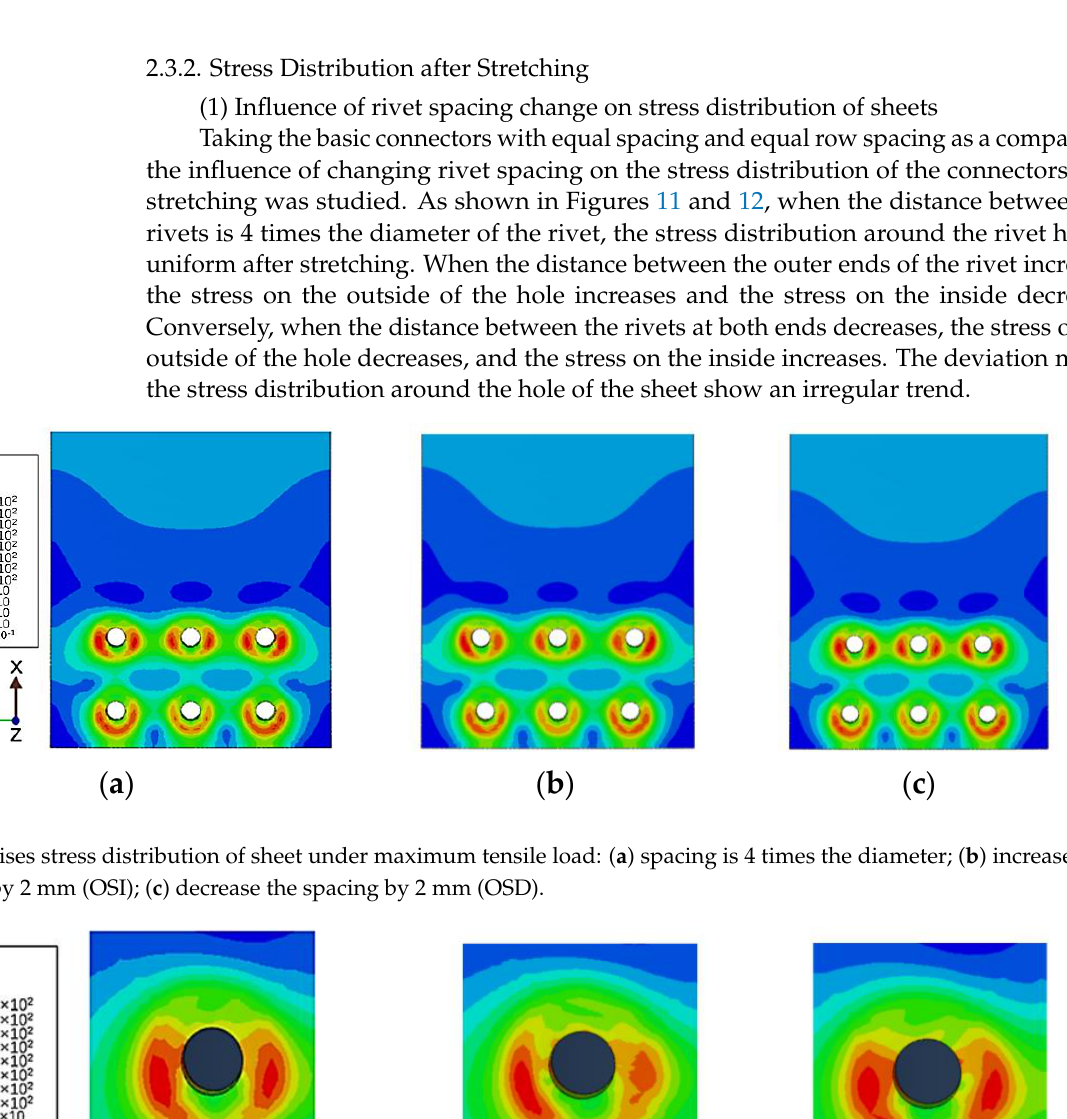
Figure 12. Schematic diagram of Mises stress distribution around the outer No. 1 rivet hole: ( a ) spacing is 4 times the diameter; ( b ) increase the spacing by 2 mm (OSI); ( c ) decrease the spacing by 2 mm (OSD).